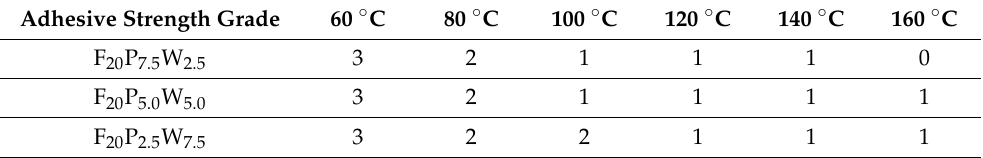
Table 6. Adhesive strength of conductive silver paste paint films containing Ag MFs, Ag NWs, and Ag NPs at different curing